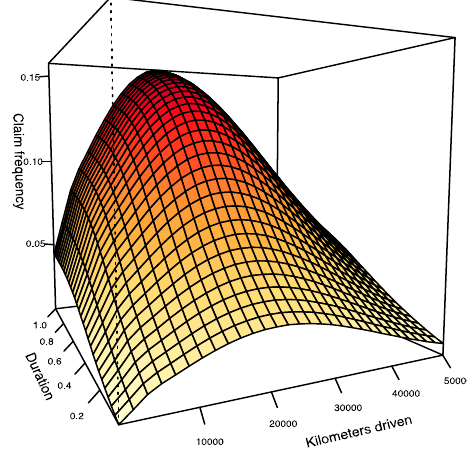
Figure 7. Model 1—Predictions surface (angle 1).